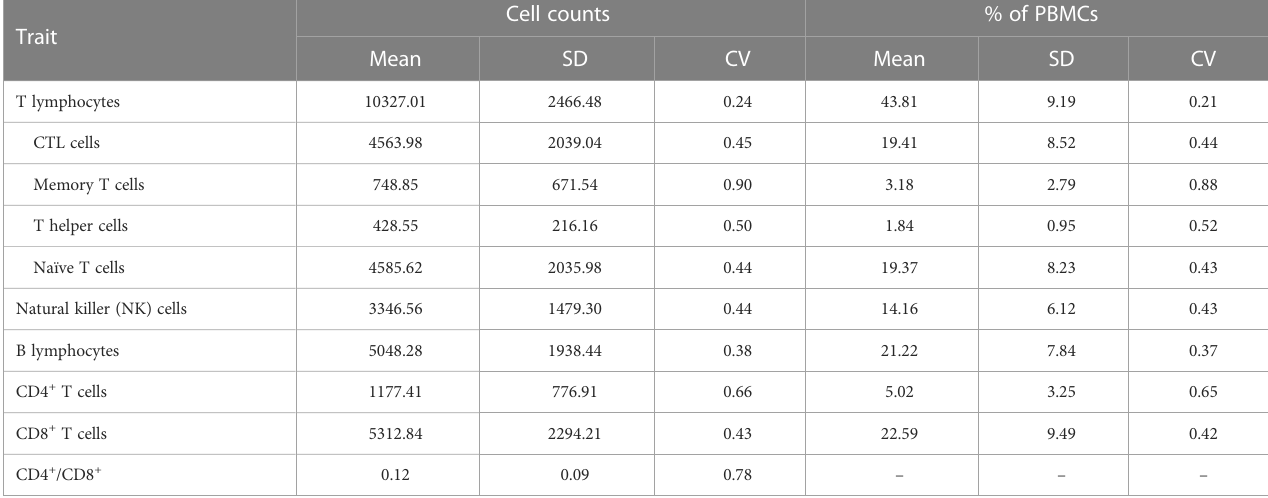
TABLE 1 Descriptive statistics of absolute numbers and proportions of peripheral blood mononuclear cells (PBMCs).